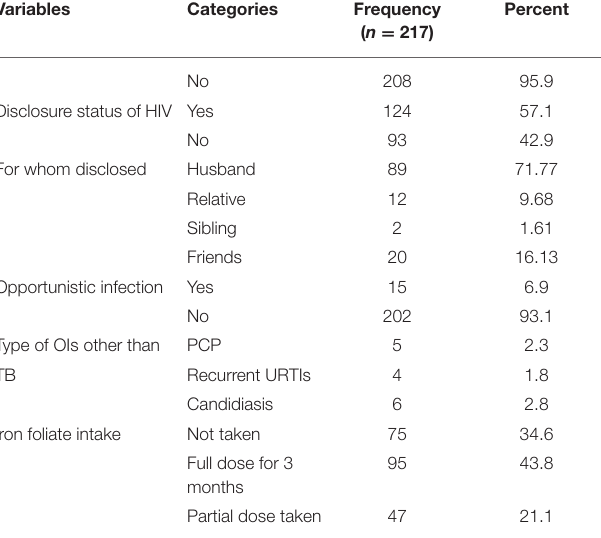
TABLE 1 | Socio-demographic status of HIV positive mothers enrolled to option B + PMTCT program in the Amhara regional state referral hospitals,